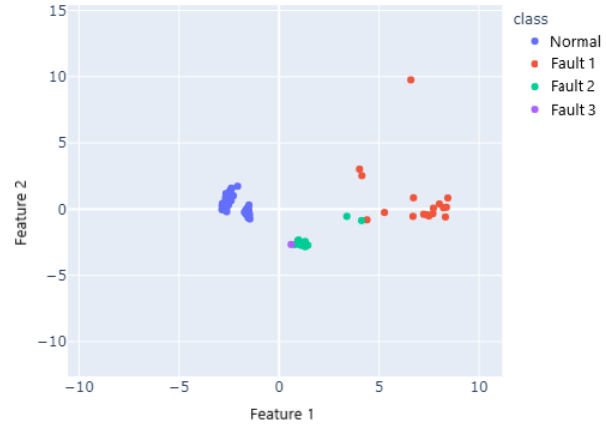
Figure 10. Distribution of samples by cluster.